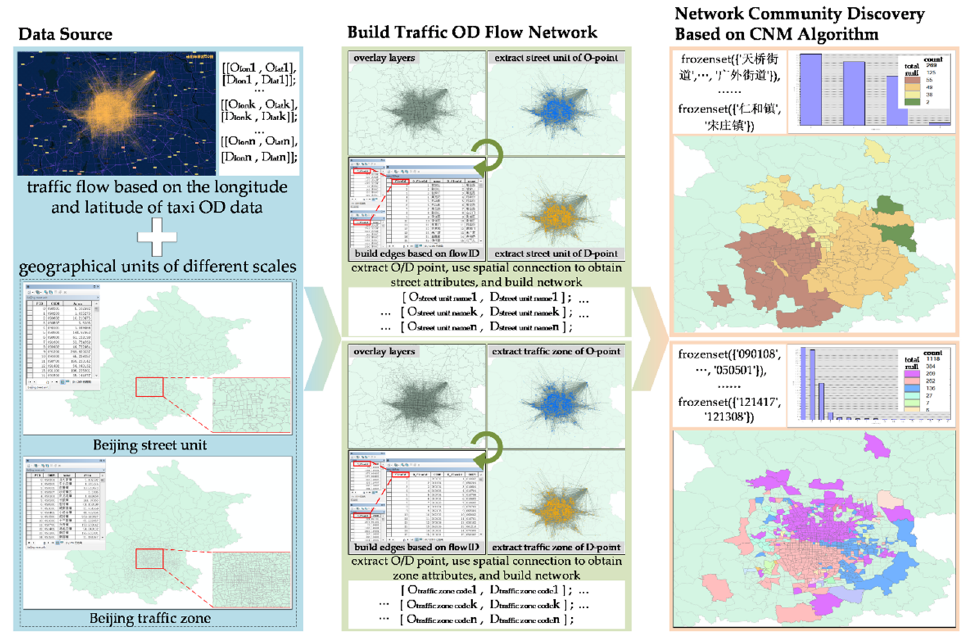
Figure 11. Discover communities using the Clauset–Newman–Moore (CNM) algorithm and visualize geographically.